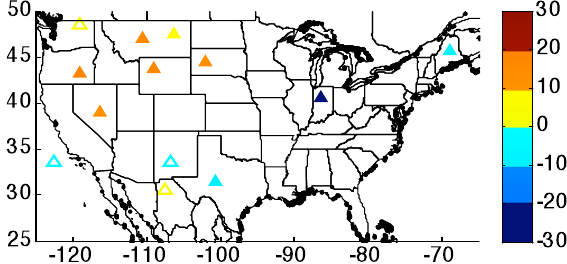
Fig. 8. Percent change in OMI-observed background NO 2 columns. Open triangles show where the change is < ± 5% while the solid triangles show where the change is ≥±